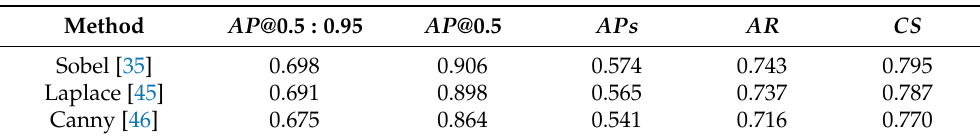
Table 5. Comparison results of edge detection operators on the WHU aerial image dataset. The best results are in